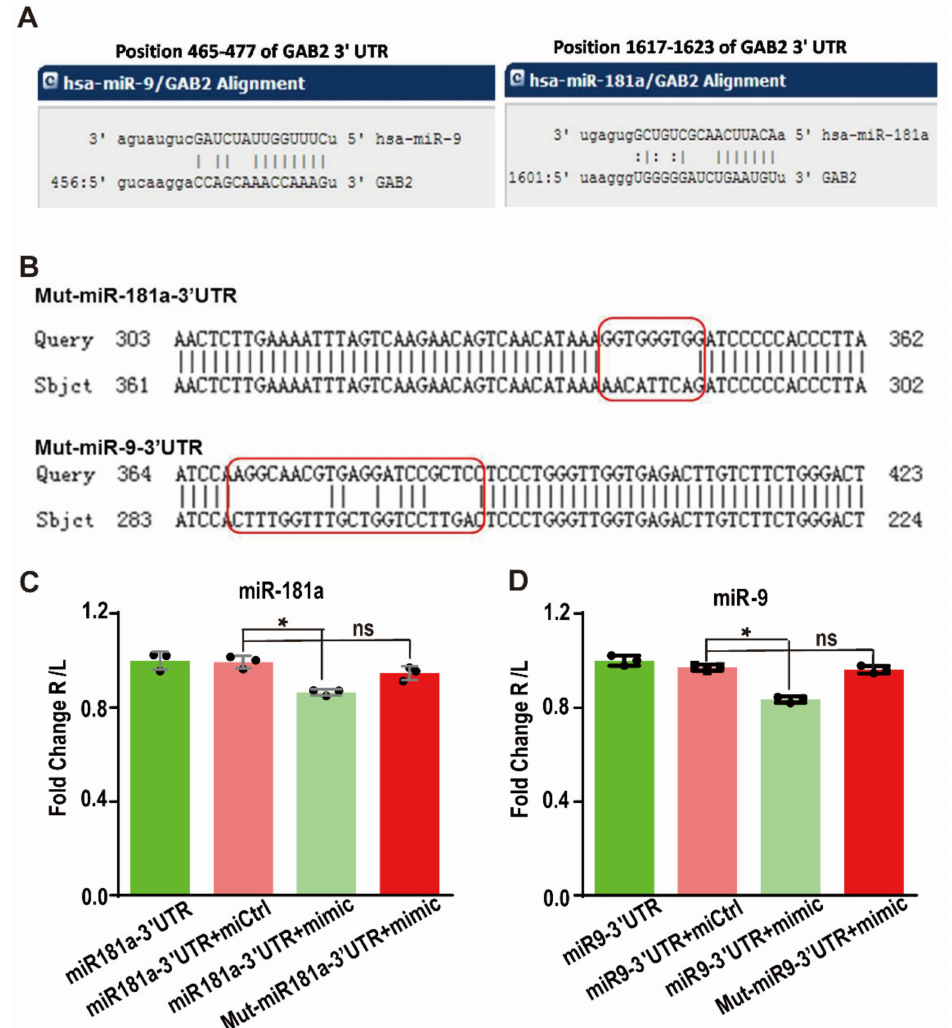
Figure 3. Targeted regulation of Gab2 by hsa-miR-9 and hsa-miR-181a. ( A ) Gab2 binding sites in hsa-miR-9 and hsa-miR-181a predicted by bioinformatics websites. ( B ) miRNAs with mutation of the Gab2 3 (cid:48) UTR binding site. ( C , D ) Analysis of the interaction between Gab2 and hsa-miR-9 ( C ) or hsa-miR-181a ( D ) by a dual-luciferase assay. The results are presented as the means ± SDs. Statistical comparisons of values were made using Student’s t -test. Red boxs indicate the mutated sequences. ns, nonsignificant; * p <